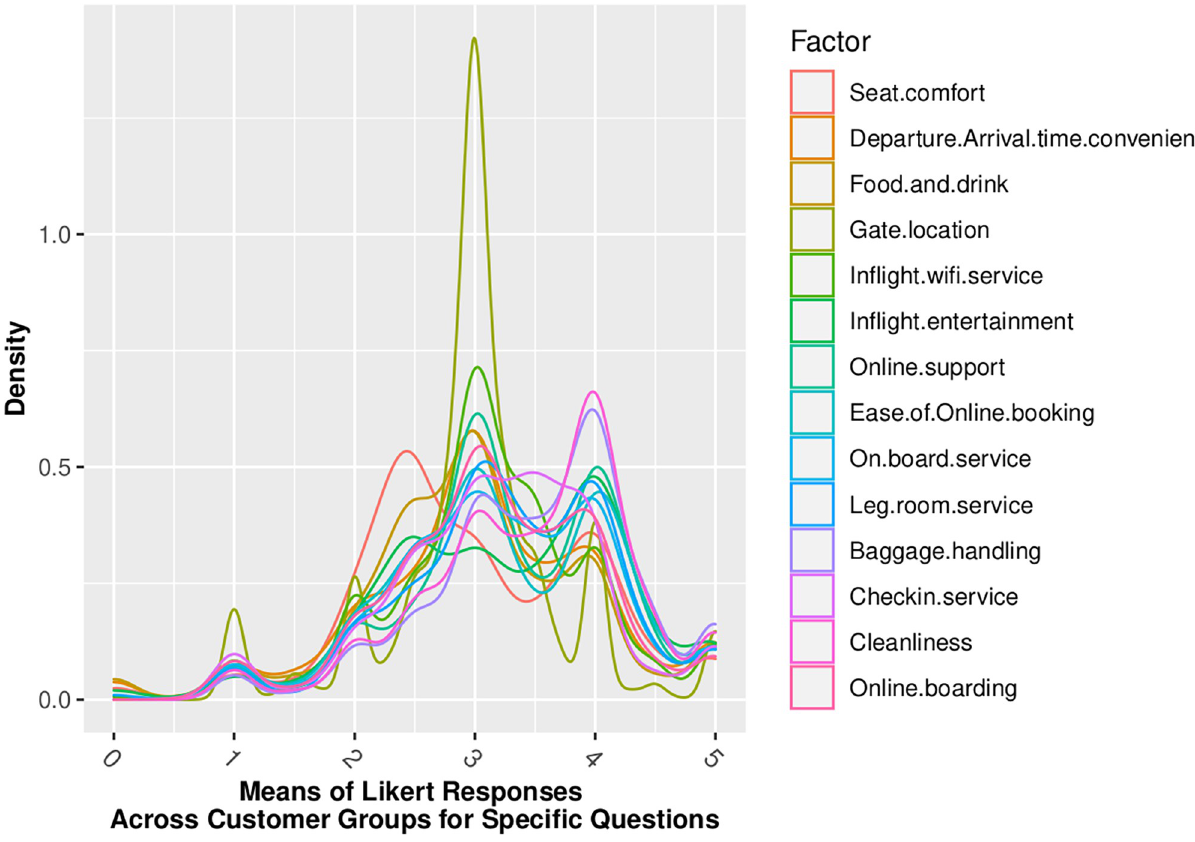
Fig 2. Means of likert responses by